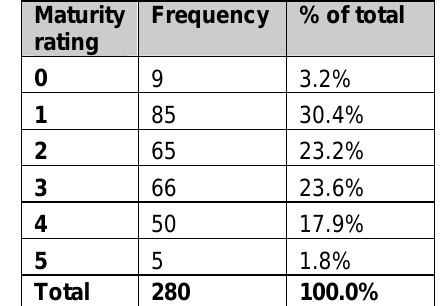
Table 6: Survey data summary by maturity distribution